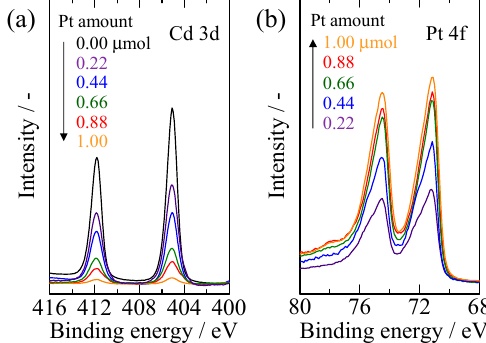
/ CdS / CuInS 2 with various Pt